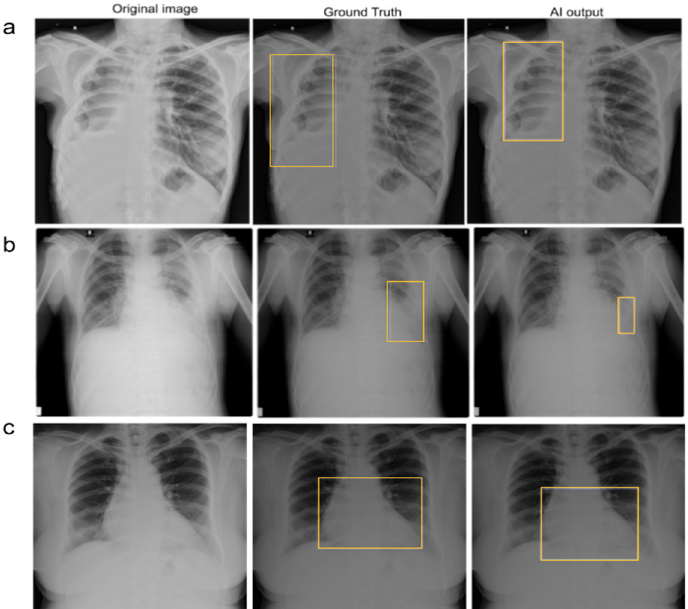
Figure 4. (Left to right) Original chest radiograph, with a ground truth bounding box indicating the presence of suspicious ROI, and an AI-generated bounding box indicating the presence of suspicious ROI in ( a ) lungs, ( b ) pleura, and ( c ) cardiac regions.